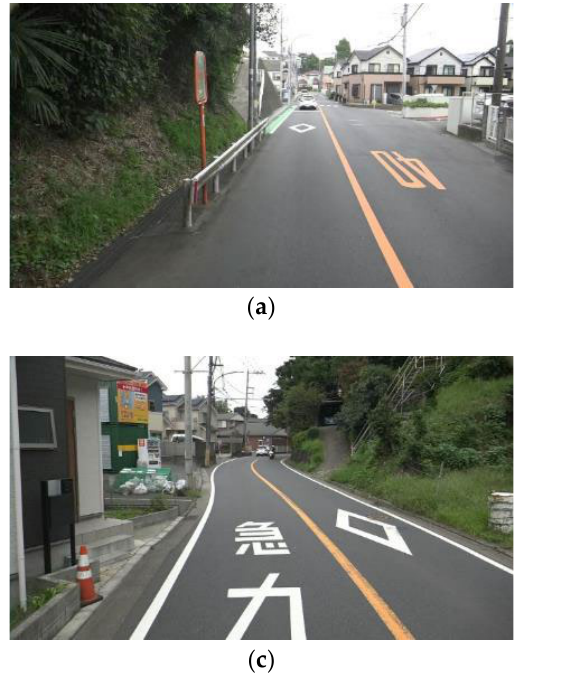
Figure 3. Examples of RMD: ( a , c ) image of scene; ( b , d ) segmentation mask. The RMD is divided into the training and test sets at a ratio of approximately 9:1, which correspond to 2990 and 321 images, respectively. Table 2 shows the ID and RGB value of each category, and the numbers of images for each category in the training set, test set, and the total. Because the road surface in each image may involve several road markings (Figure 1e), including the same road marking in plural, the number of instances of each category is more than the number of images for each category. The RMD needs to be perfected by adding more road-surface images with symbolic road markings due to the problem of class imbalance, shown in Table 2. Table 2. Summary of the Road Marking Dataset (RMD) compiled by this study.